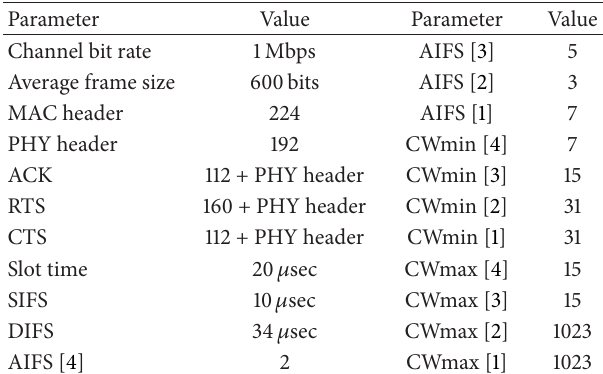
Table 1: DSSS system parameters and access category parameters used in simulation.